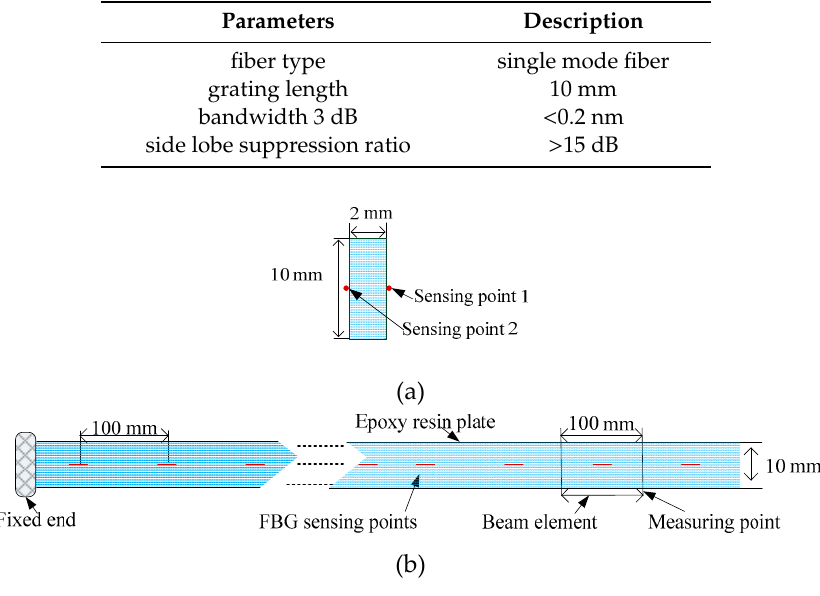
Figure 8. Schematic diagram of the FBG flexible sensor. ( a ) Side view of the sensor; ( b ) Front view of the sensor.